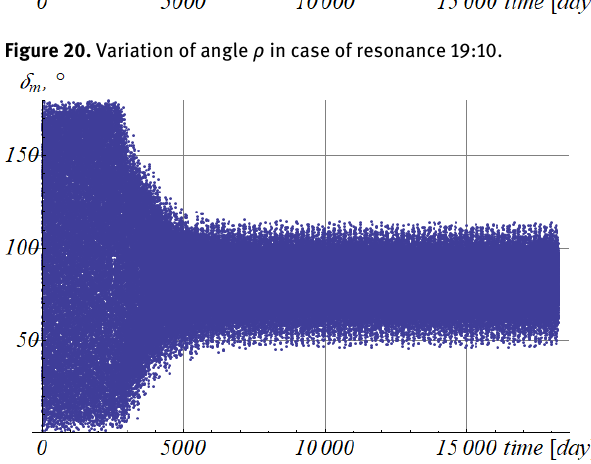
Figure 21. Variation of angle δ m in case of resonance 19:10. Table 1. Simulations with zero magnetic moment and S = S 0 .